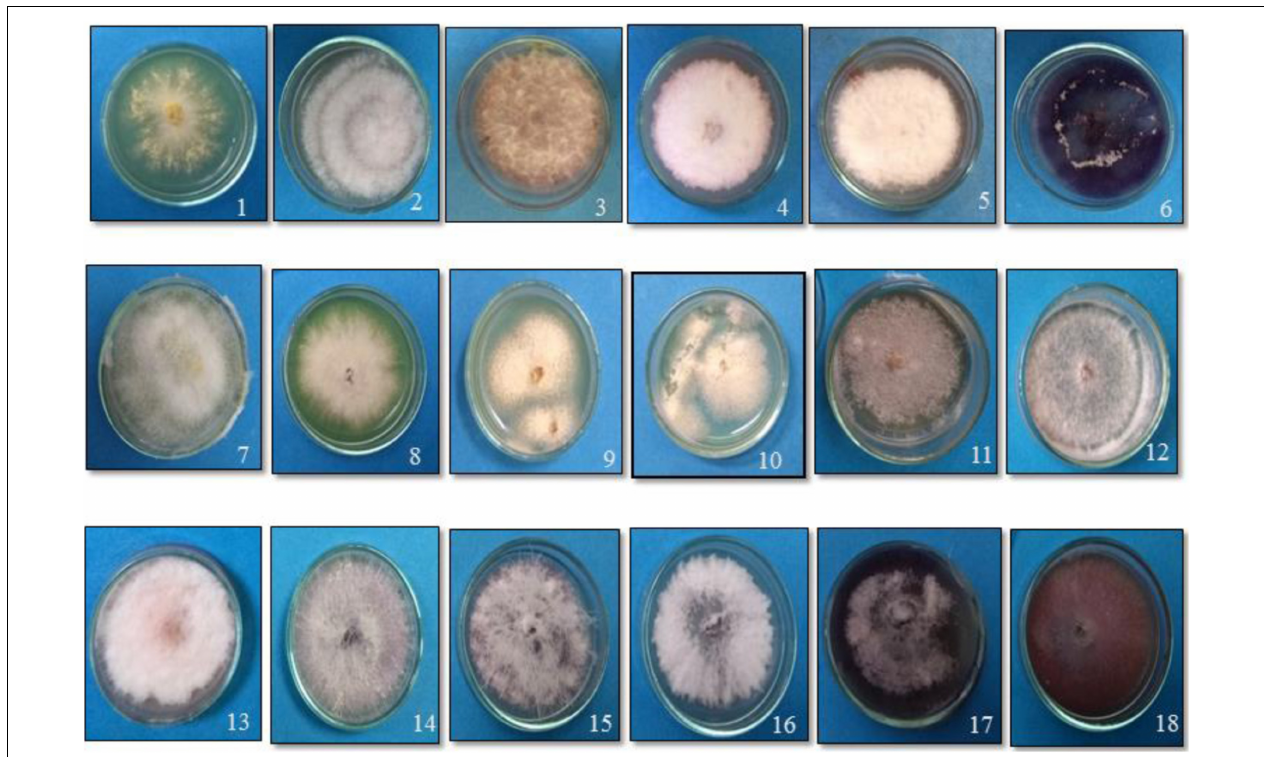
FIGURE 1 | Growth of the putative Fusarium isolates of tomato on potato dextrose agar medium. (1) TOFOL-IHBT; (2) TOFU-2-SOGHI; (3) TOFU-3-B.GHAT; (4) TOFU-IHBT; (5) TOXX- POT-1; (6) TOXX- POT- 2; (7) TOFU-KOTBEJA-1; (8) TOFOL-CBE; (9) TOFS-CPCT-2; (10) TOFS-3-CPCT; (11) TOFU-MM; (12) TOFS-MU; (13) TOFU-4-CPCT; (14) TOFU- 6-CPCT; (15)TOFU-TISSA-4; (16) TOFS-IIVR; (17) TOFU-SN; (18)